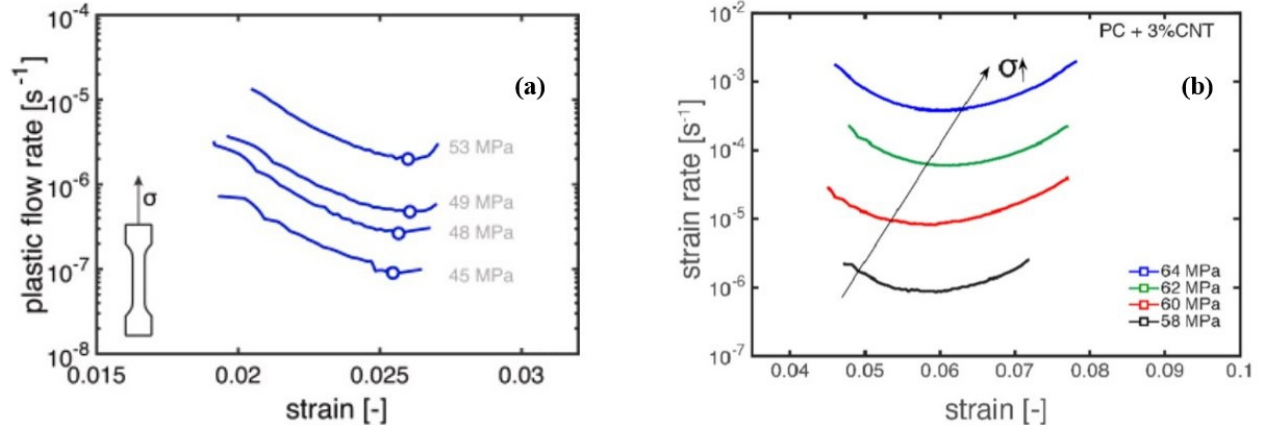
Figure 8. Sherby–Dorn plots for ( a ) glass-fibre reinforced iPP composites [72], and ( b ) polycarbonate/CNT composites [69], tested in uniaxial creep at 23 °C under various stresses.